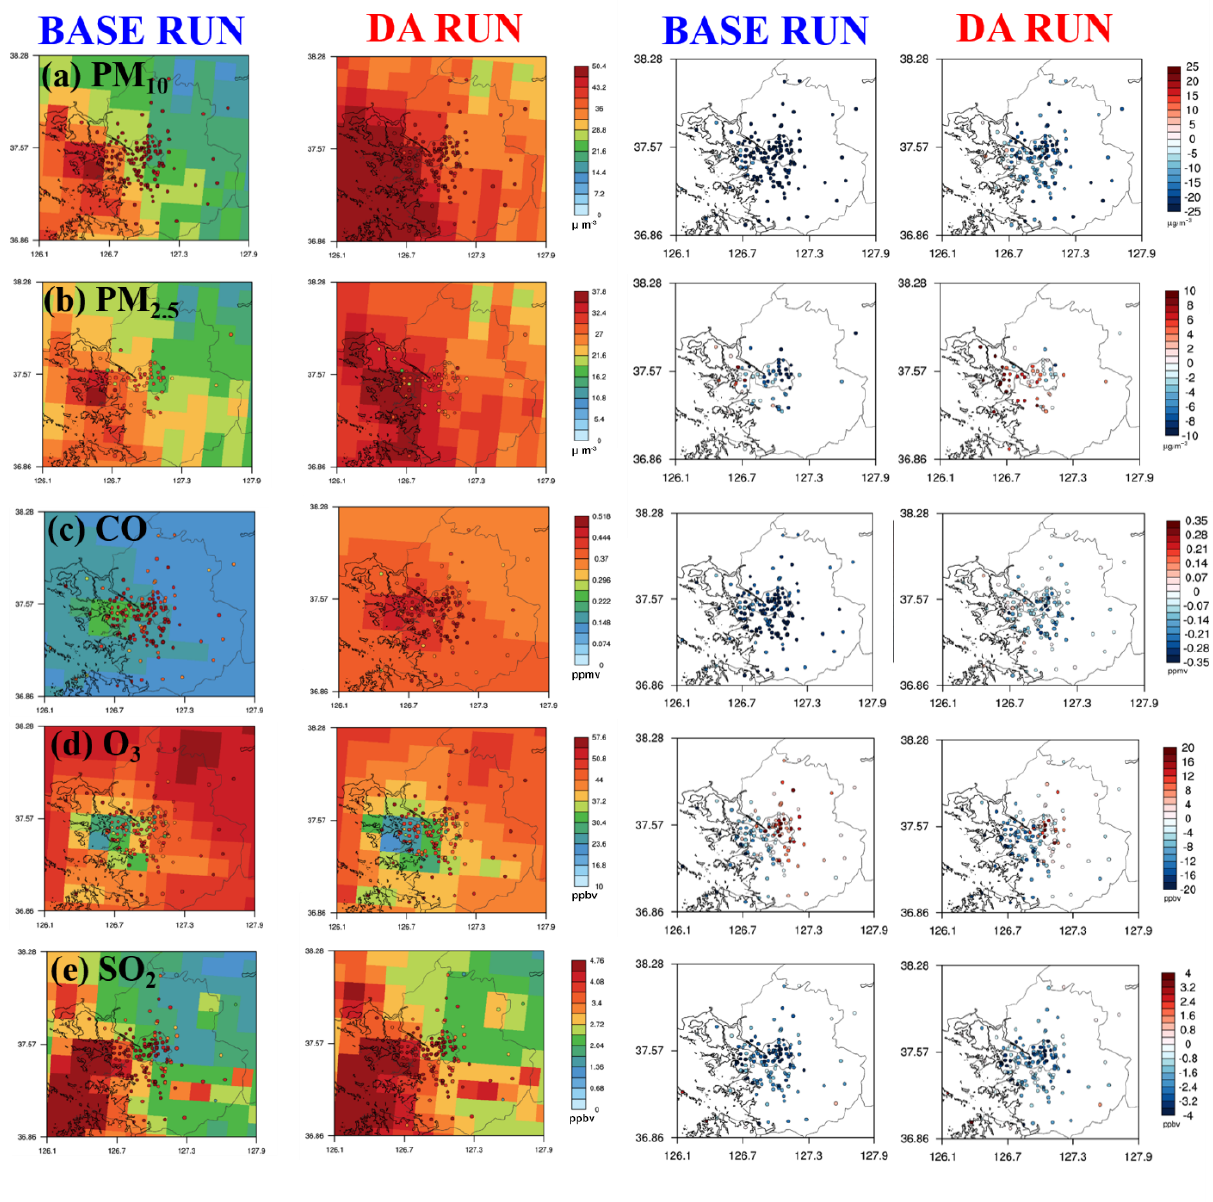
Figure 10. Spatial distributions (first and second columns) and bias (third and fourth columns) of (a) PM 10 , (b) PM 2 . 5 , (c) CO, (d) O 3 and (e) SO 2 over Seoul metropolitan area (SMA) for the entire period of the KORUS-AQ campaign. Colored circles of first and second columns represent the concentrations of the air pollutants observed at the Air Korea stations in the